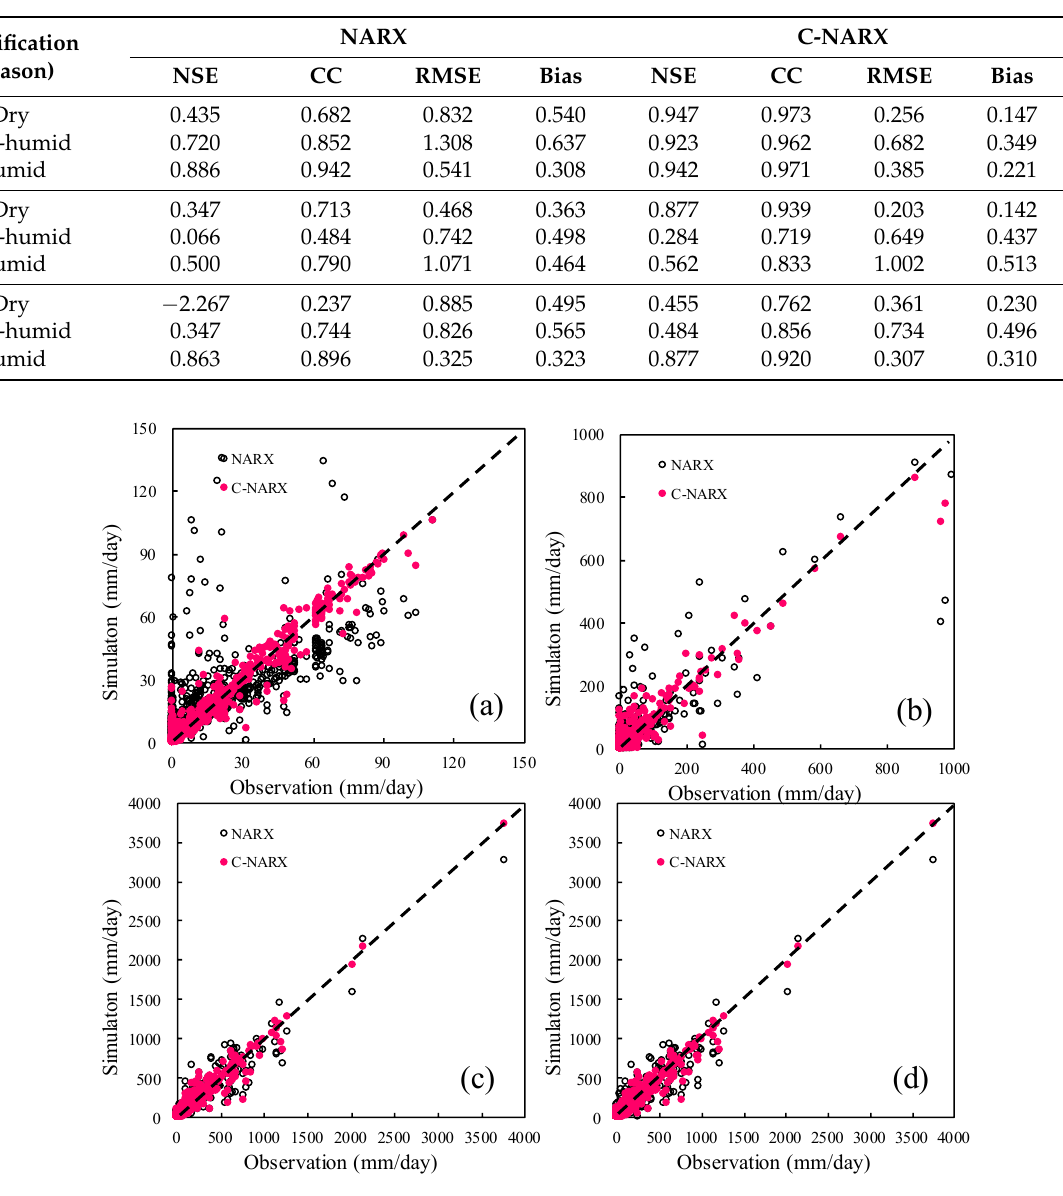
Figure 3. Comparison of simulation and observation values between NARX and C-NARX models in training period with the dry season ( a ), semi-humid season ( b ), humid season ( c ) and all years ( d ).